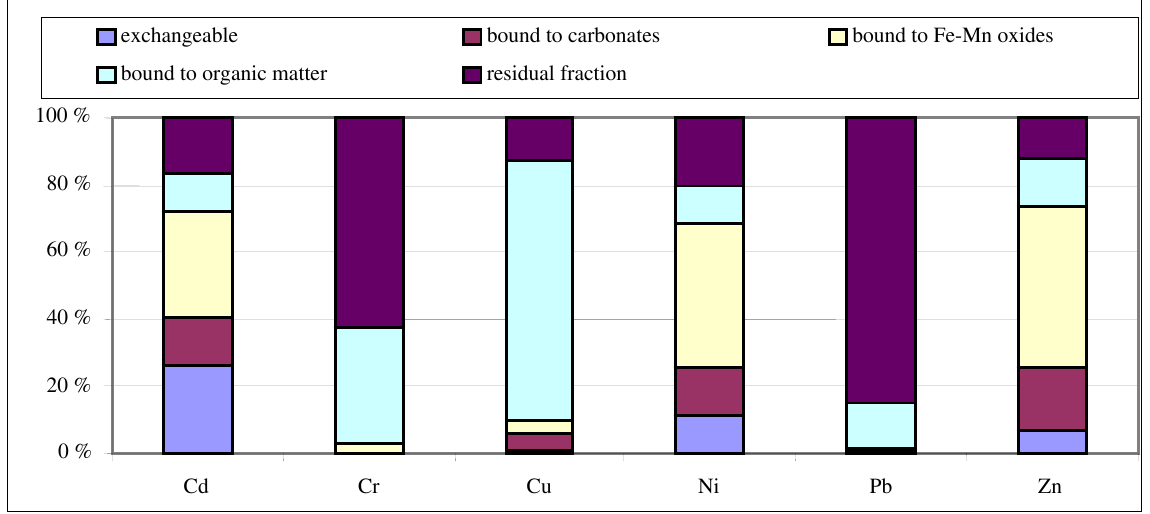
Fig 3. Distribution of heavy metals in soil fractions of sewage sludge